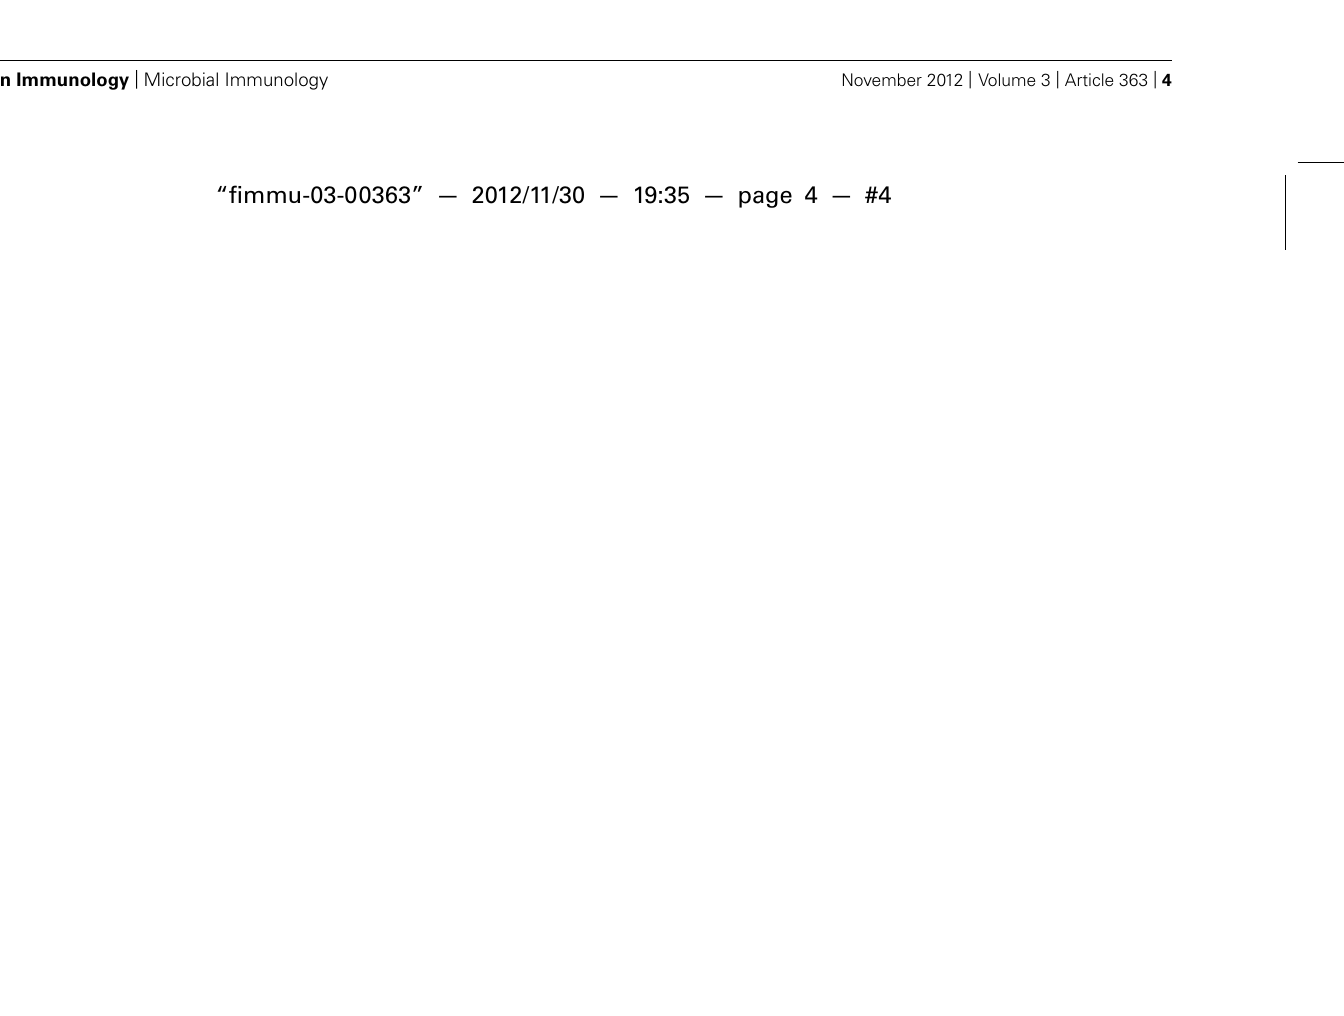
show EA recruiting PKD at the invasion sites. Confocal microscopy followed by Huygens Surface Rendering (www.svi.nl). Magnification bars = 4 μ m (A) and 5 μ m (B)